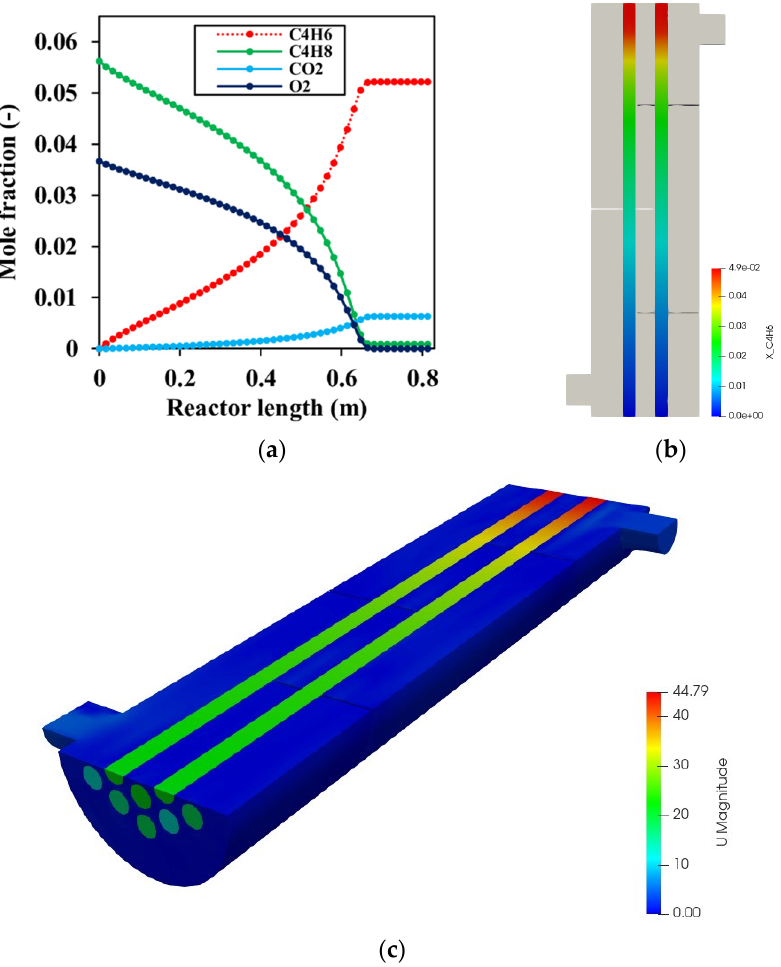
Figure 9. Mole fractions distribution and mole fraction contour plot under adiabatic conditions: ( a ) mole fraction distributions of each species; ( b ) contour plot of butadiene mole fraction; ( c ) 3D velocity profile.